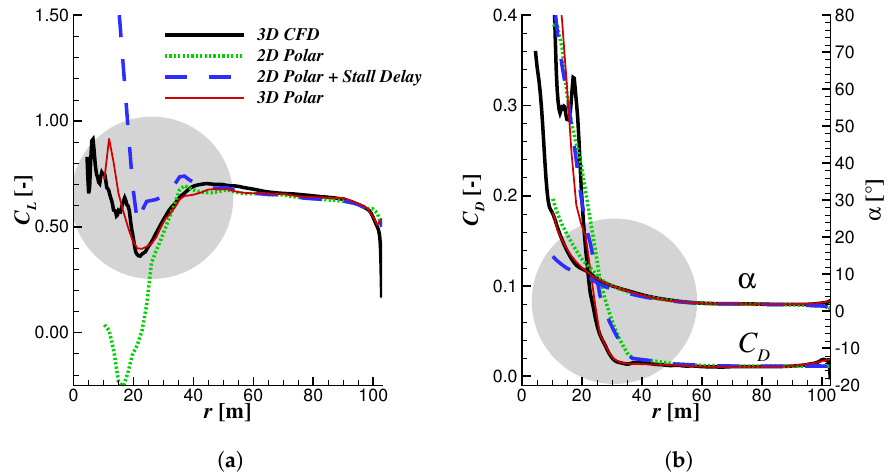
Figure 9. Effects of various polar datasets on the accuracy of BEM predictions in terms of ( a ) C L and ( b ) C D and α